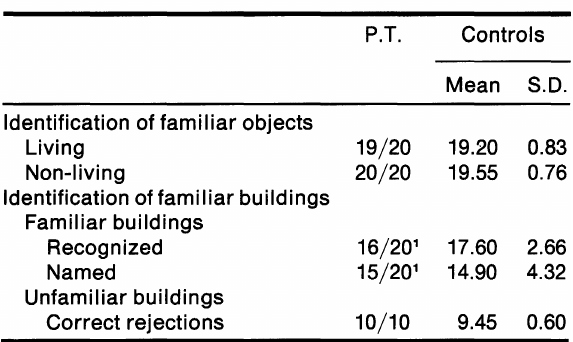
TABLE III. P.T.'s ability to identify objects and